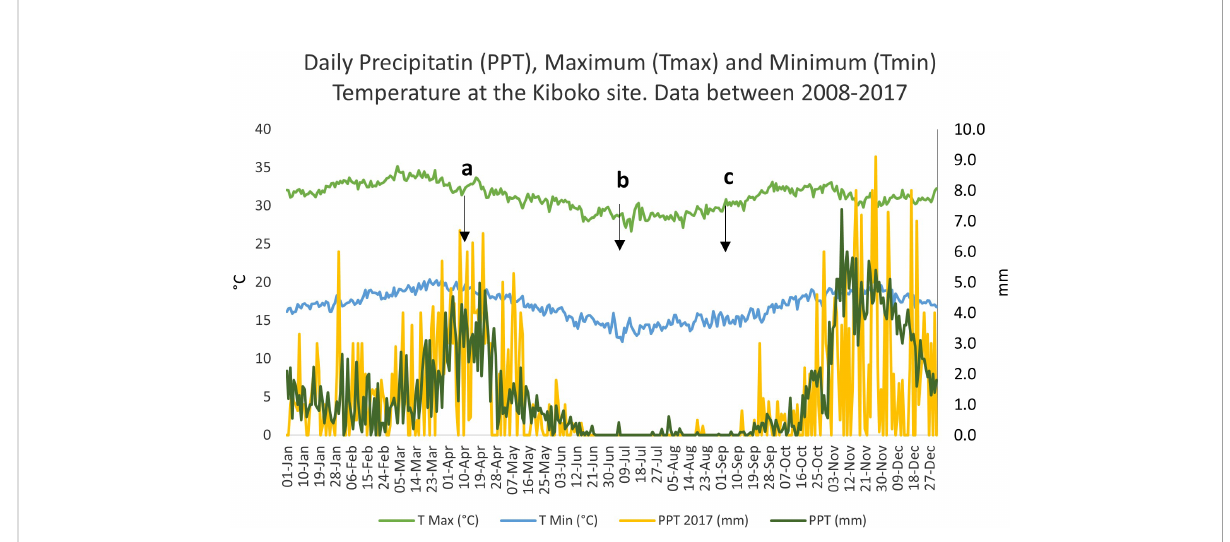
FIGURE 1 Daily Precipitatin (PPT), Maximum (Tmax) and Minimum (Tmin) Temperature at the Kiboko site. Data between 2008-2017. a, maize and cowpea sowing; b, cowpea harvest; c, maize